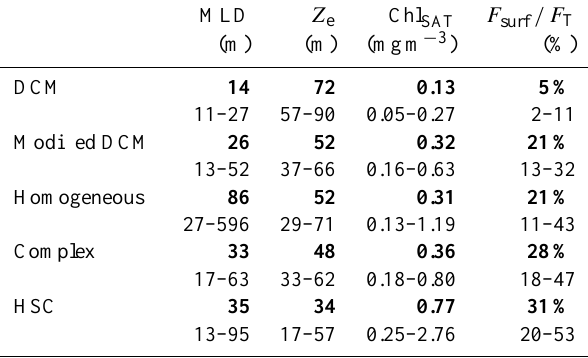
Table 3. Median value (bold) and first and ninth decile for the fol- lowing parameters: MLD, euphotic depth ( Z e ), surface [Chl a ] ob- served by satellite (Chl SAT ) and percentage of chlorophyll content in the upper 20m layer compared to the total integrated content ( F surf / F T